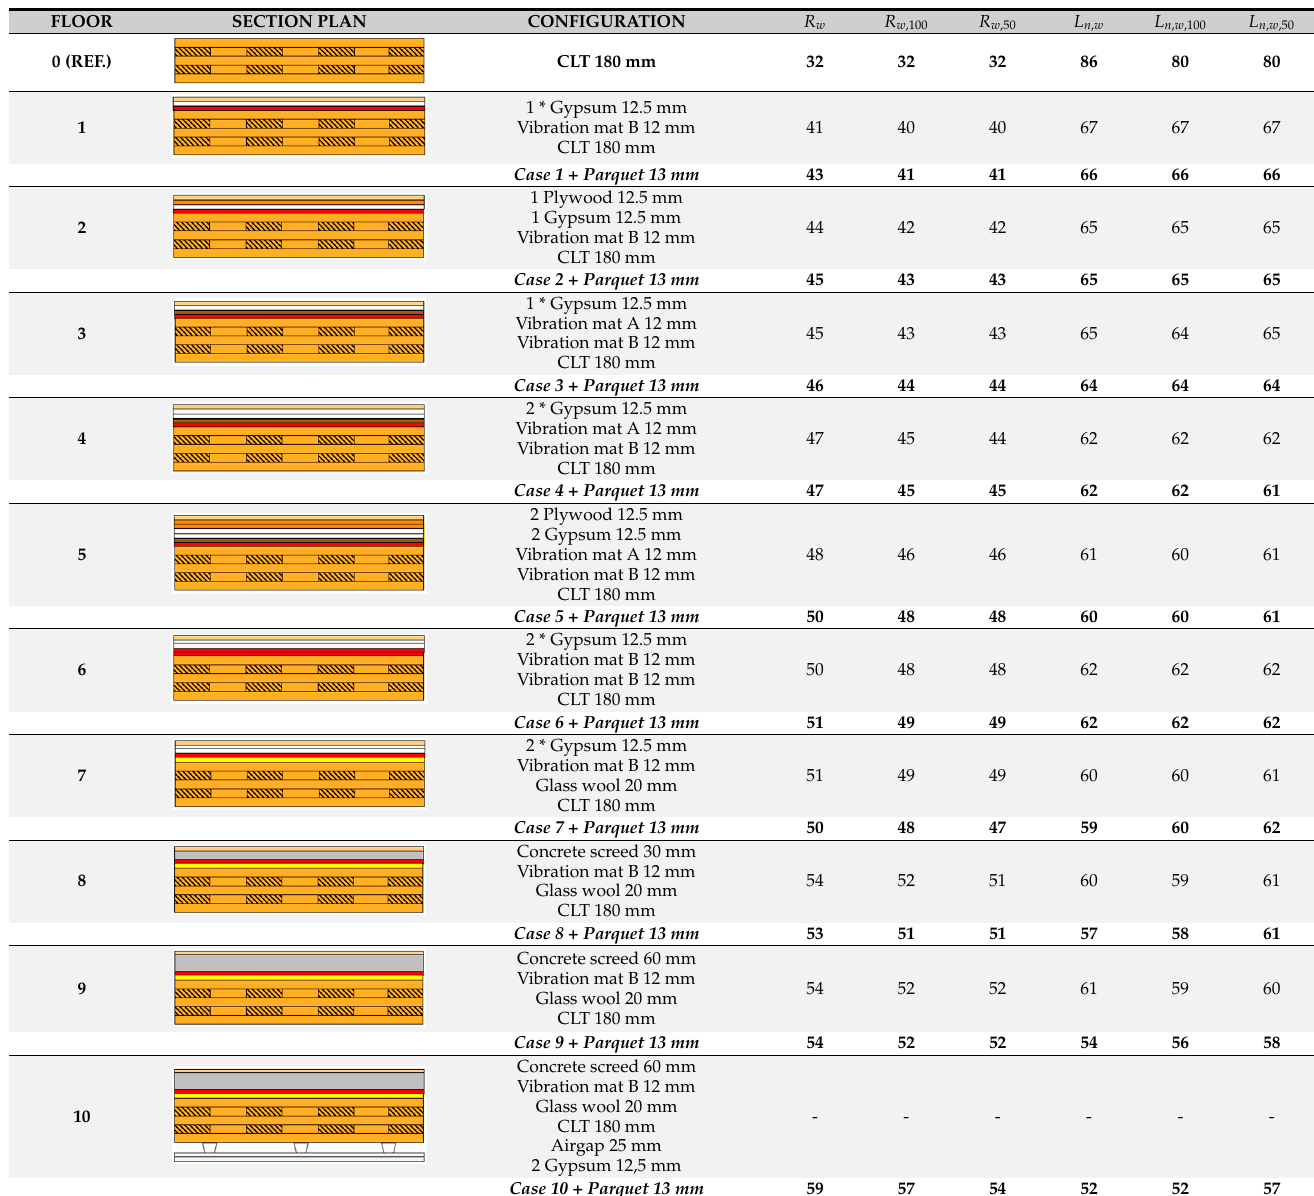
Table 1. Overview of material properties of the study. Table 2. Overview of test floor cases with acoustic descriptors in dB.